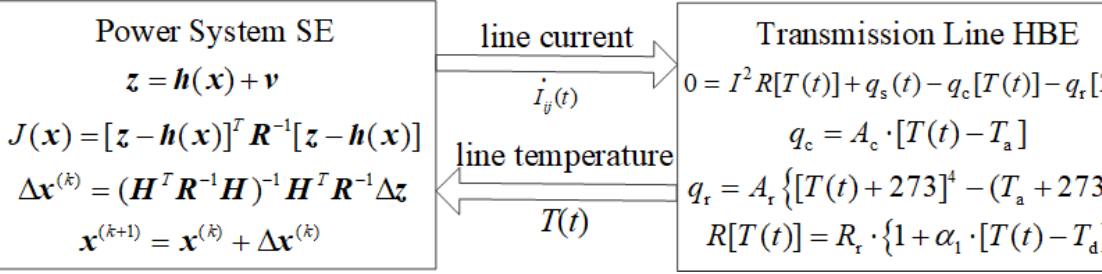
8 of 17 Figure 2. Flowchart of the proposed AJ-ETC-ES approach. 4. Improved Two-Step ETC-SE Approach 4.1. Framework of Improved Two-Step ETC-SE The framework of the proposed ITS-ETC-SE approach can be illustrated in Figure 3. The SE and temperature estimation are decoupled and solved via alternate iteration. At